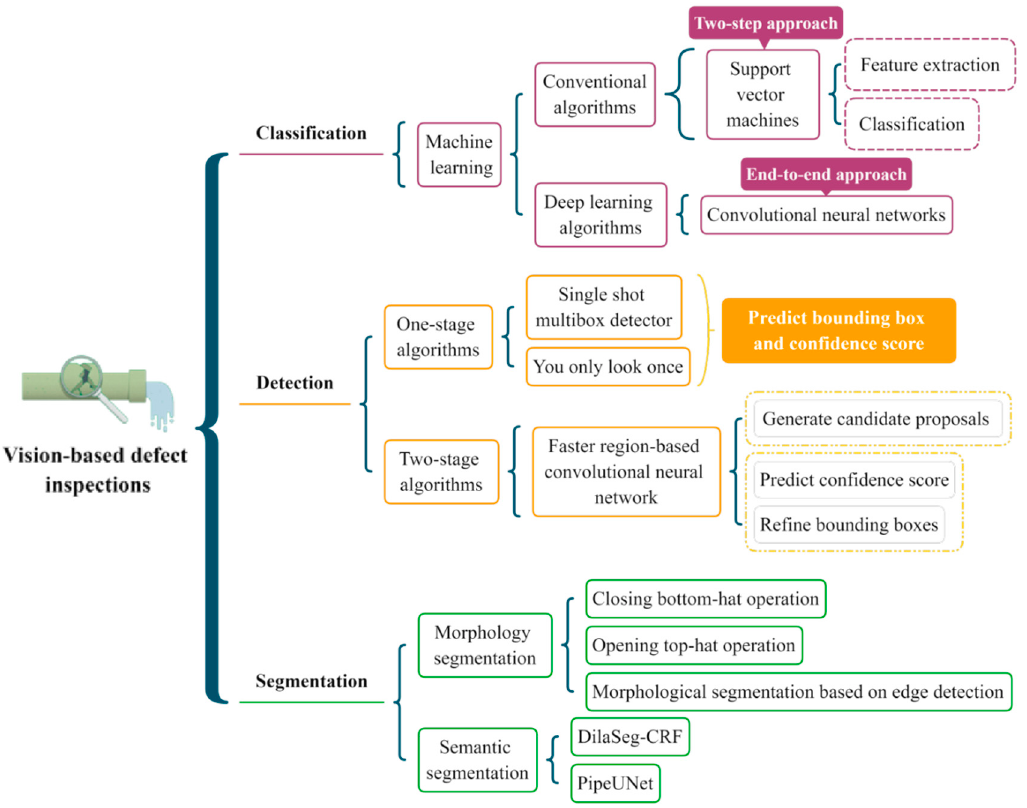
Figure 4. The classification map of the existing algorithms for each category. The dotted boxes represent the main stages of the algorithms.